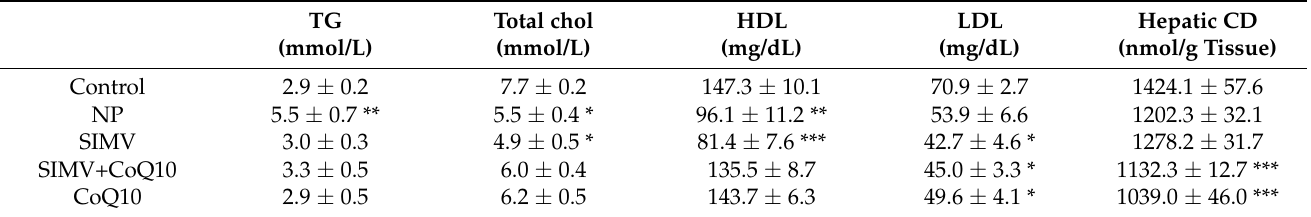
Table 3. Lipid profile and hepatic conjugated diene concentration in the control group and groups treated with empty nanoparticles (NP), simvastatin-loaded nanoparticles (SIMV), a combination of simvastatin-loaded and coenzyme-Q10-loaded nanoparticles (SIMV+CoQ10), and coenzyme-Q10- loaded nanoparticles